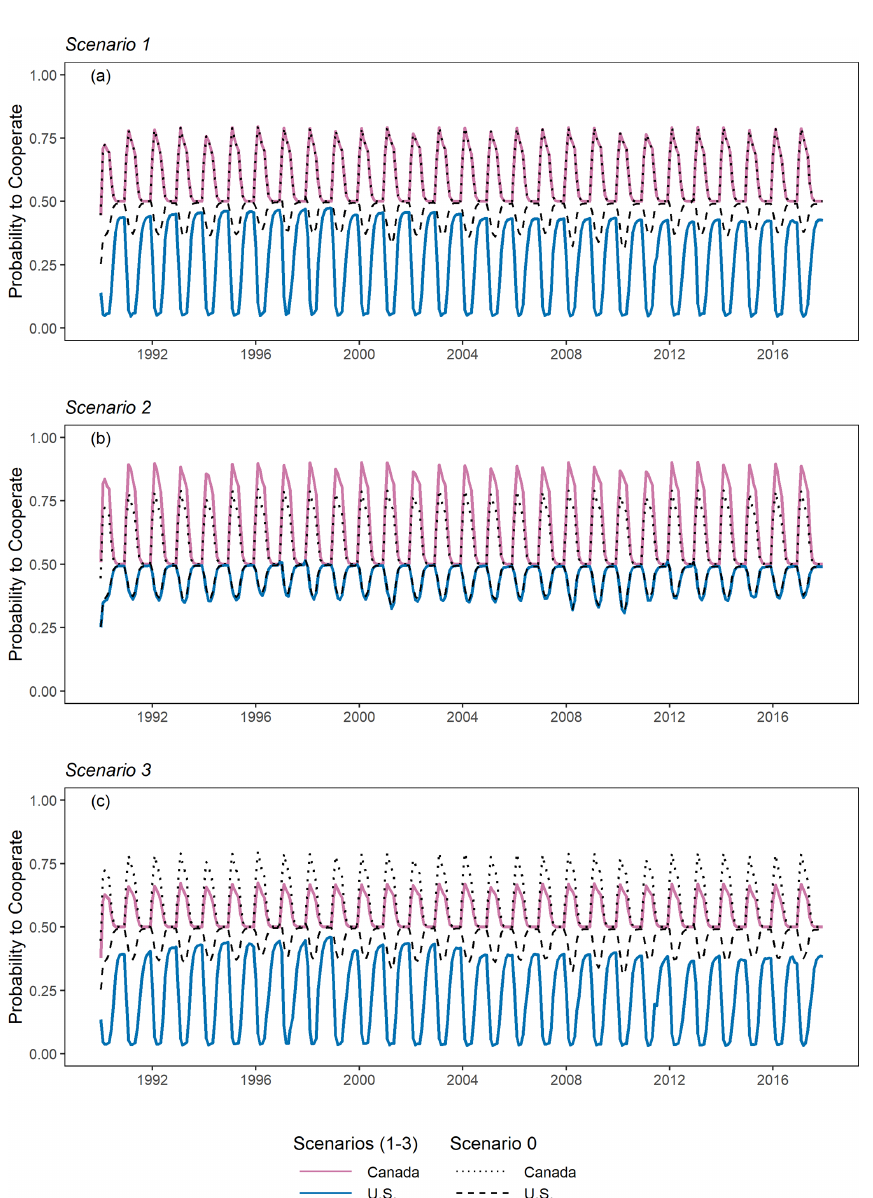
Figure 10. The probability to cooperate of each country according to different scenarios: (a) Scenario 1, (b) Scenario 2, and (c) Scenario